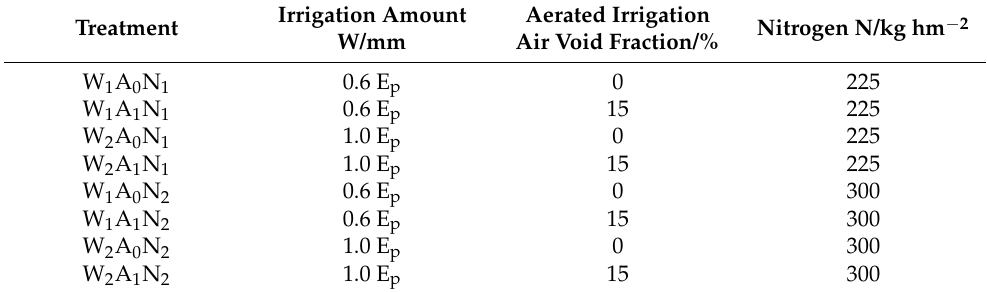
Table 2. Experimental design.